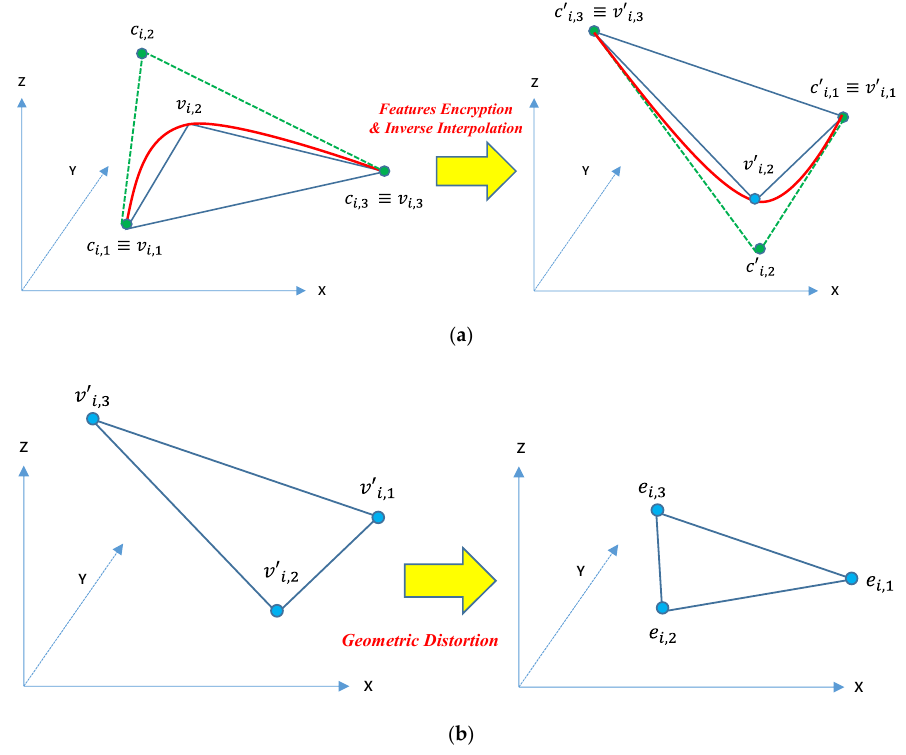
Figure 4. Facet encryption: ( a ) features encryption and inverse interpolation; ( b ) geometric distortion.